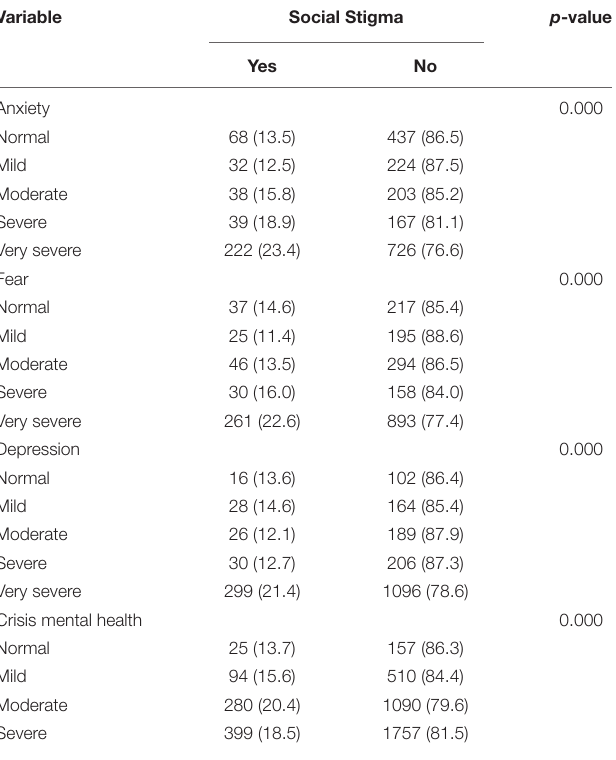
TABLE 4 | Predictors social stigma caused anxiety, fear, depression, and crisis mental health during pandemic. Variable Social